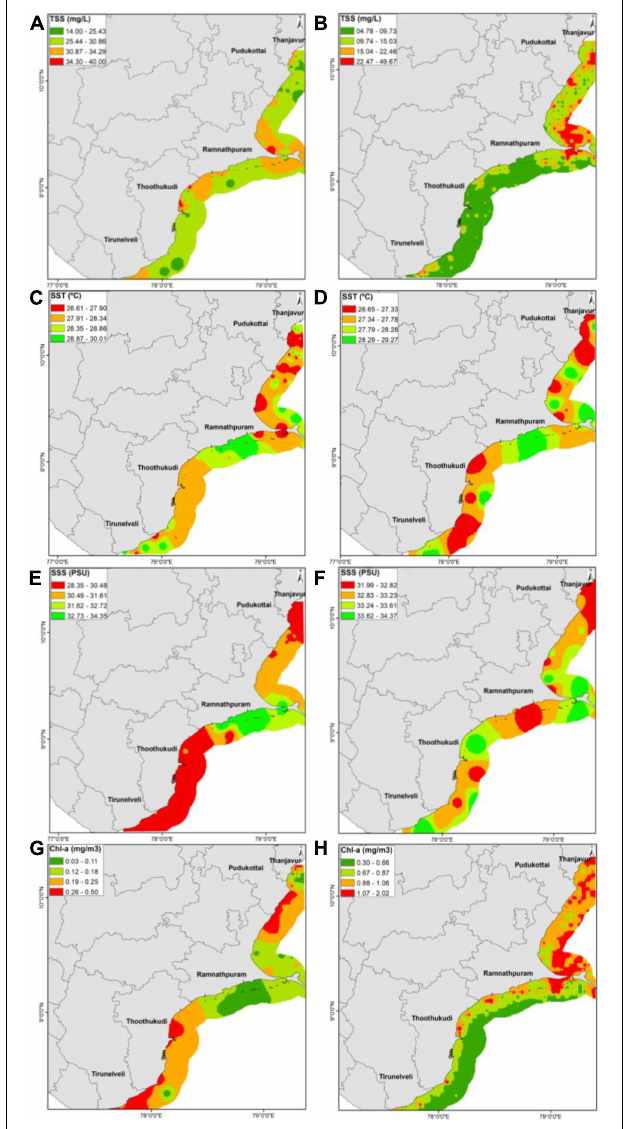
FIGURE 2 | (A–H) In-situ (A,C,E,G) and satellite (B,D,F,H) data comparison along the Tamil Nadu coast.